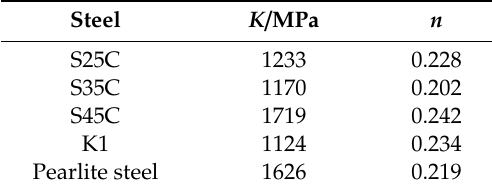
Table 2. Material constants of Ramberg–Osgood